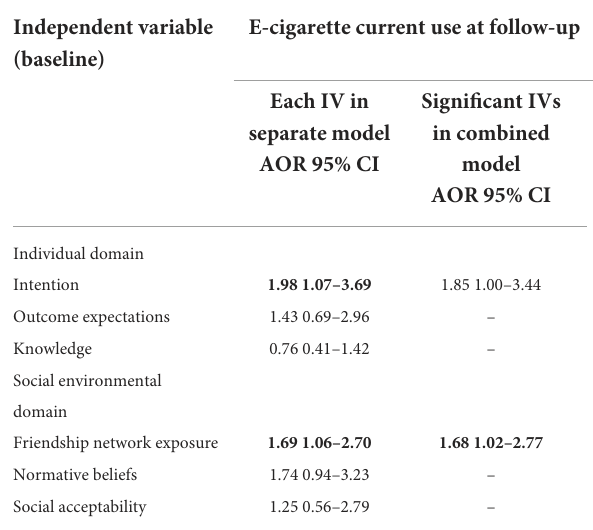
TABLE 3 Regression models predicting e-cigarette current use at follow-up, with independent variables (IVs) first entered in separate models and significant IVs entered into a combined model ( n =